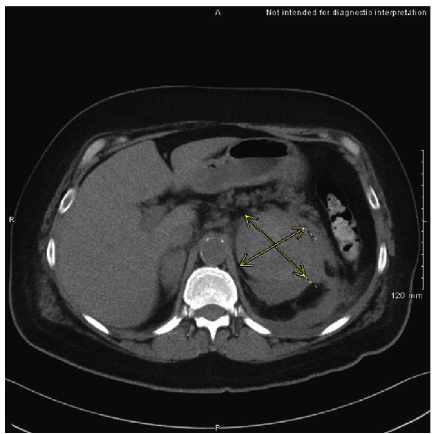
Figure 1: Demarcation of Left adrenal hemorrhage.